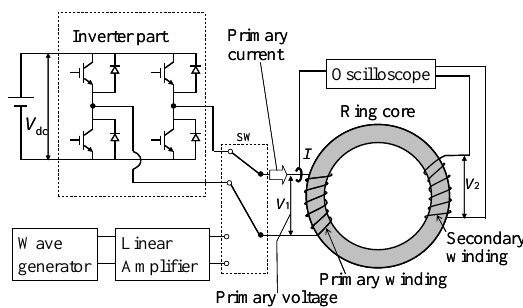
Figure 5. Measurement system using inverter excitation and linear amplifier excitation.